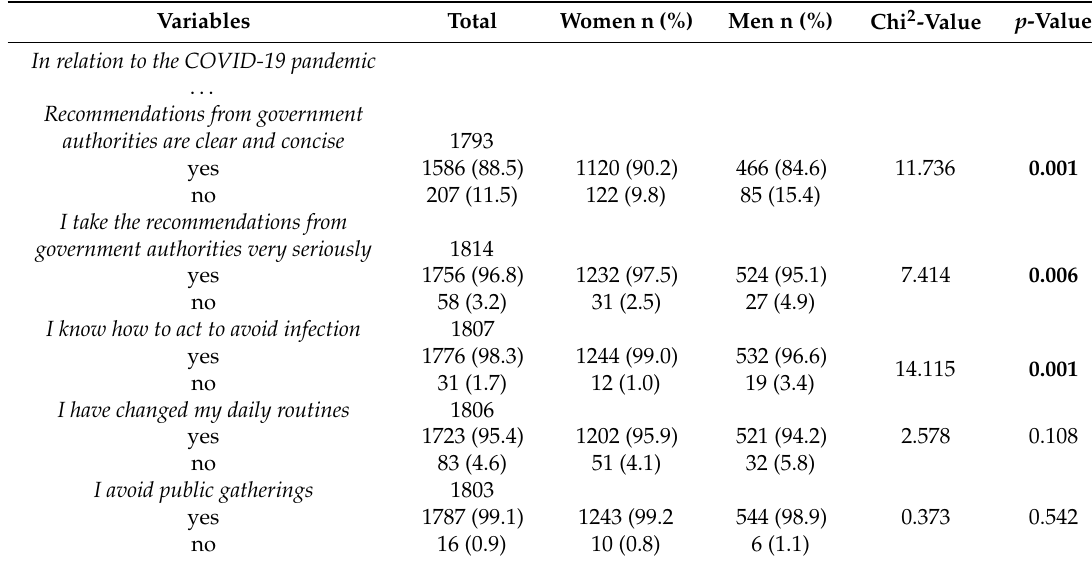
Table 3. Perceptions concerning recommendations based on gender (number, percentage and Chi 2